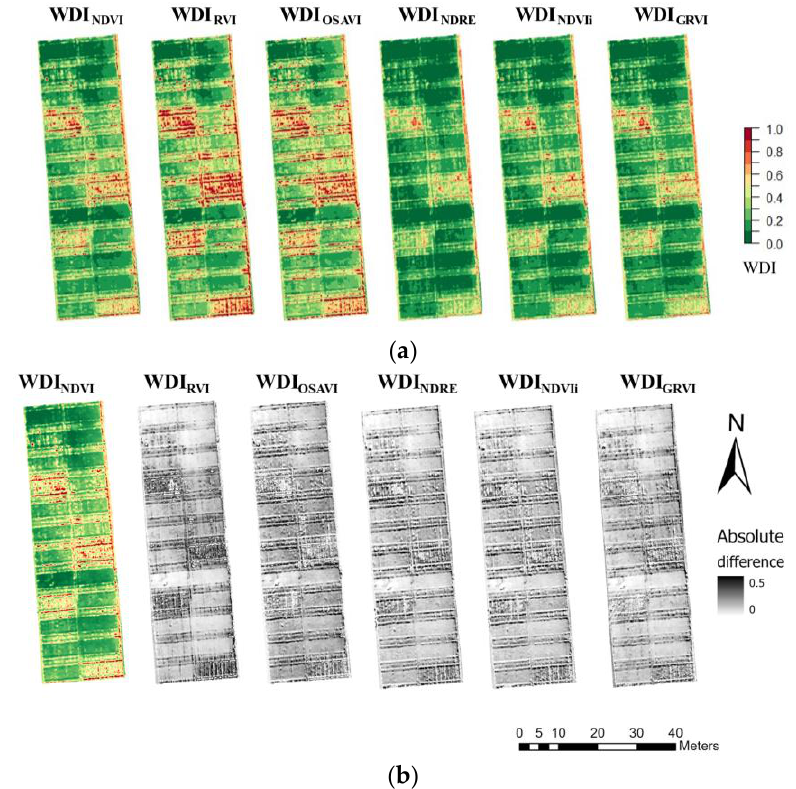
Figure 5. ( a ) Water Deficit Index (WDI) maps calculated from different multispectral indices for the winter wheat based on the flight carried out on 15 April 2019 and ( b ) absolute difference map between WDI NDVI and other WDIs. NDVI is the Normalized Difference Vegetation Index; RVI—Ratio Vegetation Index; OSAVI—Optimized Soil-Adjusted Vegetation Index; NDRE—Normalized Difference Red Edge; NDVIi—Red and Red Edge NDVI; GRVI—Green and Red ratio Vegetation Index.